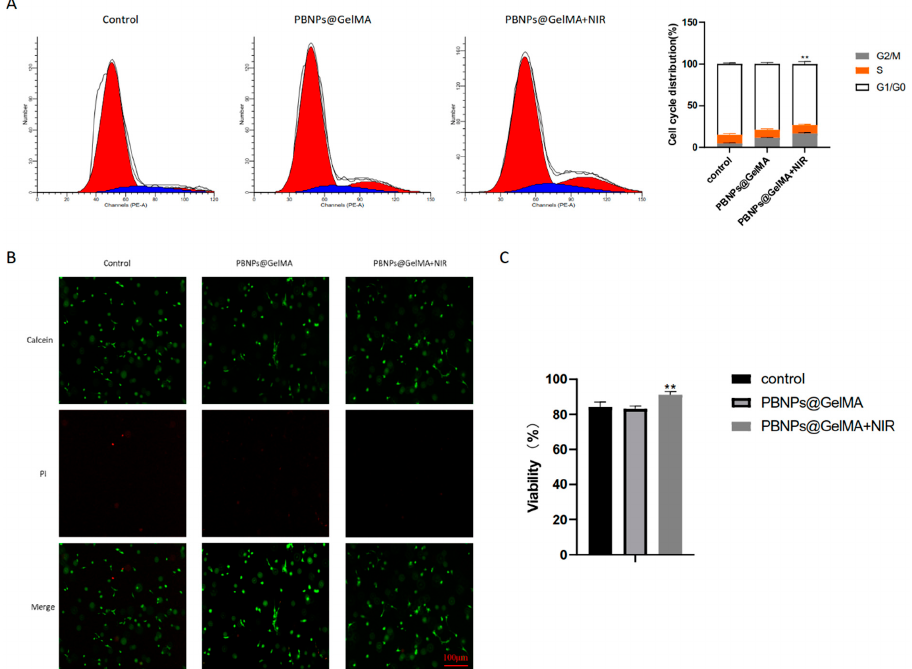
Figure 2. Heat shock treatment induced by PBNP@GelMA regulated the behavior of MSCs. ( A ) Flow cytometry assay to explore the cell cycle. ( B ) Fluorescence image of the Live/dead assays. Green fluorescent cells are alive, and red fluorescent cells are dead. ( C ) Viability calculated by Live/dead assays (n = 3). Samples without implants were used as a control group; ** p < 0.01.